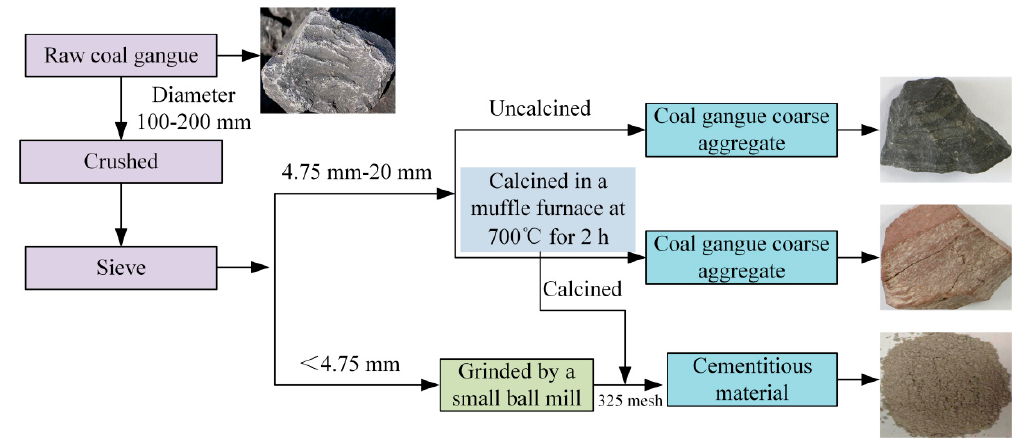
Figure 1. Production process of coal gangue aggregate.